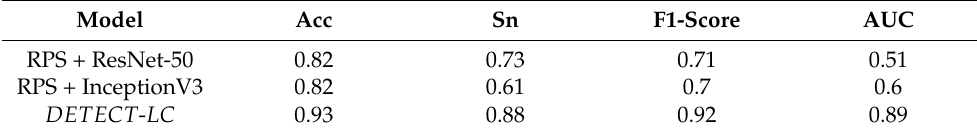
Table 6. Lung Cancer Phenotyping Performance Evaluation on NSCLC Radio